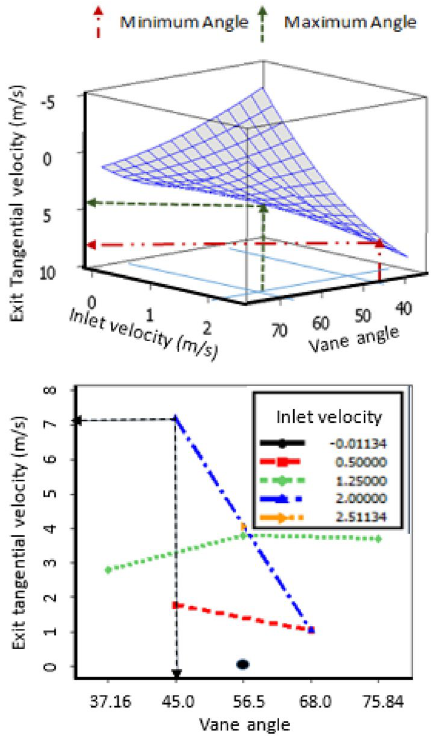
Fig. 14 RSM analysis results. Top: Three-dimensional surface plot showing the maximum and minimum exit tangential velocities with different inlet velocities and vane angles. Bottom: Interaction plot of maximum and minimum exit velocities with different inlet velocities and vane